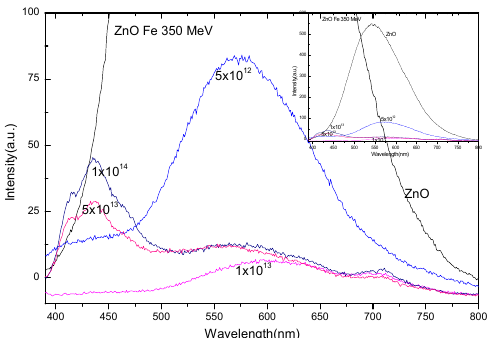
Figure 4. PL spectra of ZnO irradiated with 56 Fe 21 + ions measured by excited light at 340 nm. The image on the upper right is a panorama of the image.